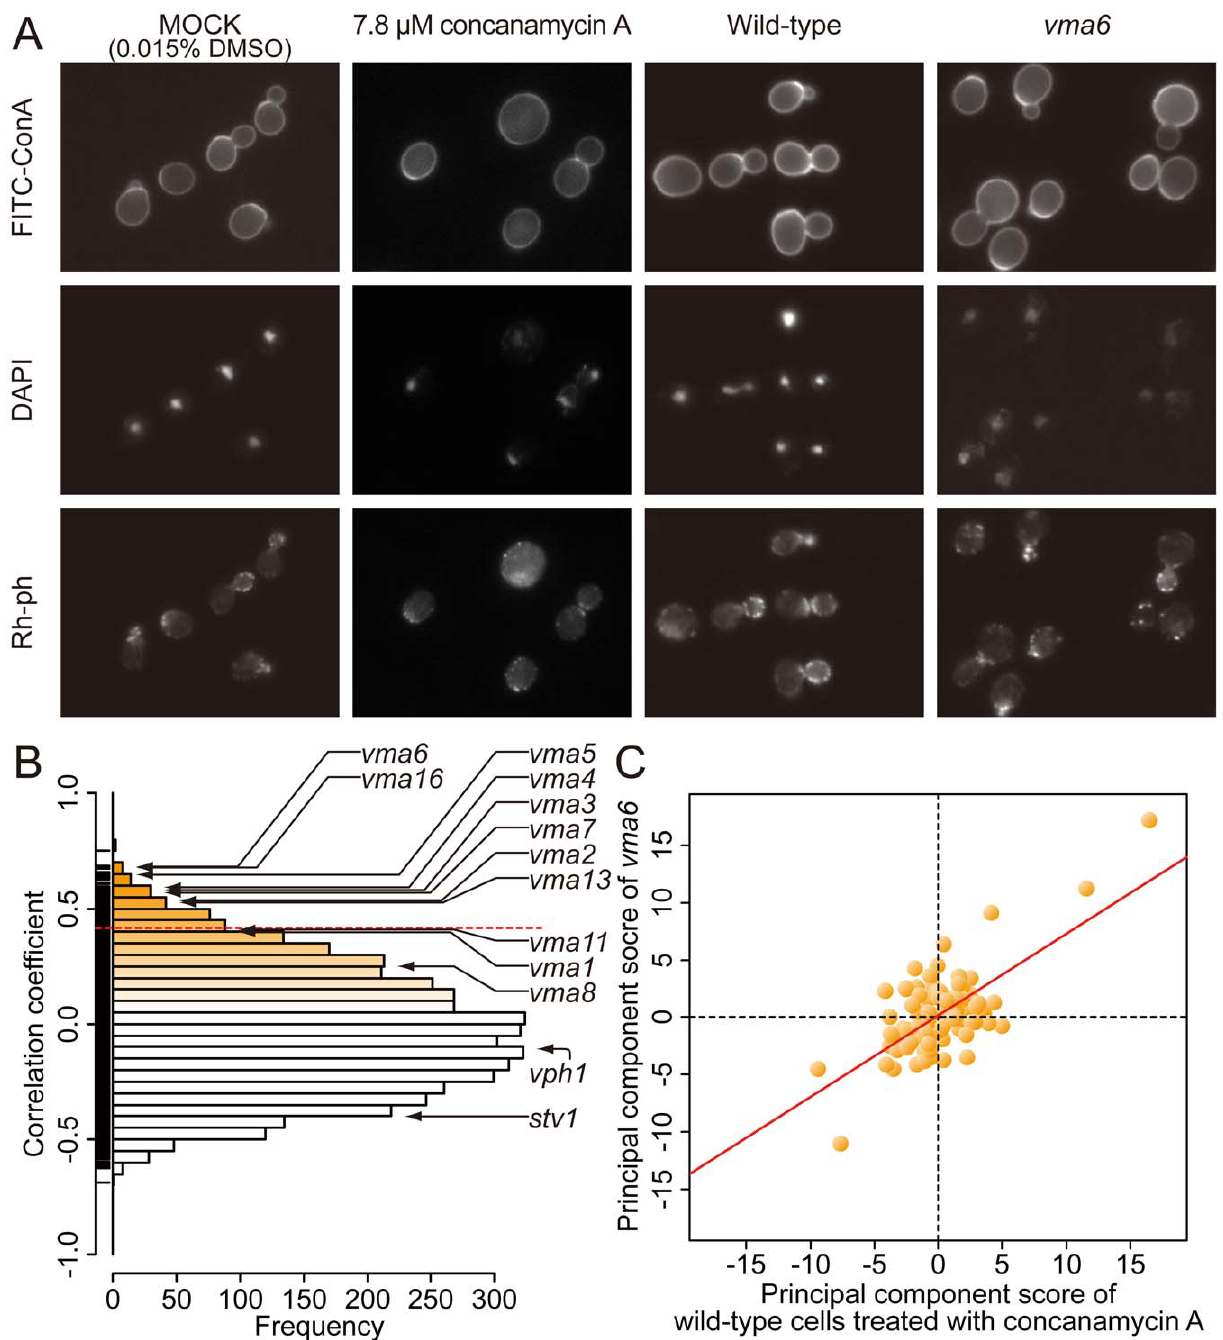
Figure 3. Concanamycin A treatment and the results of target inference. A) Photographs of wild-type cells treated with 7.8 m M concanamycin A and the vma6 mutant. Cells were triply stained with FITC-ConA, Rh-ph, and DAPI. Quantitative analysis of concanamycin A-induced morphologic changes is summarized in Table S2. B) A histogram of correlation coefficients (R) between mutant and concanamycin A-treated wild- type cells. The dashed red line indicates the position of the R value corresponding to the two sided P value of 0.05 with the Bonferroni correction based on a correlation coefficient test. C) Two-dimensional plot of concanamycin A-treated wild-type cells and the vma6 mutant. Scores for the 104 principal components are plotted. The red line represents a linear regression model